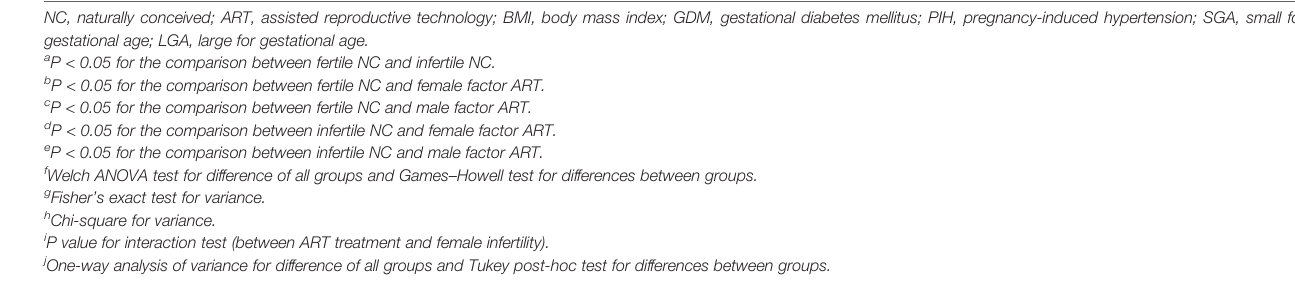
statistically signi fi cant, did not appear to be clinically signi fi cant. However, compared to the infertile NC group, their GA, BW, and BW z score were all comparable (all P > 0.05). Among the four groups, the risks of both LBW and SGA were comparable (all P > 0.05). The female factor ART group showed a higher risk of PTB and LGA compared to the fertile NC group (PTB: 6.5% vs. 4.0%, P < 0.05; LGA: 24.2% vs. 20.4%, P < 0.05). Compared to the infertile NC